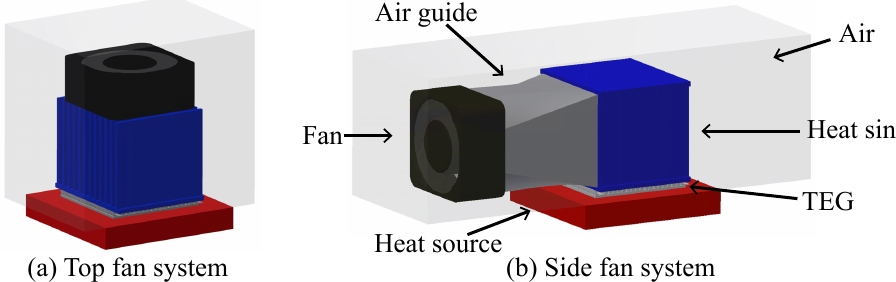
Figure 1. Thermoelectric generator (TEG) system with two different fan locations with part indication; ( a ) top-mounted fan (TMF) (baseline) and ( b ) side-mounted fan